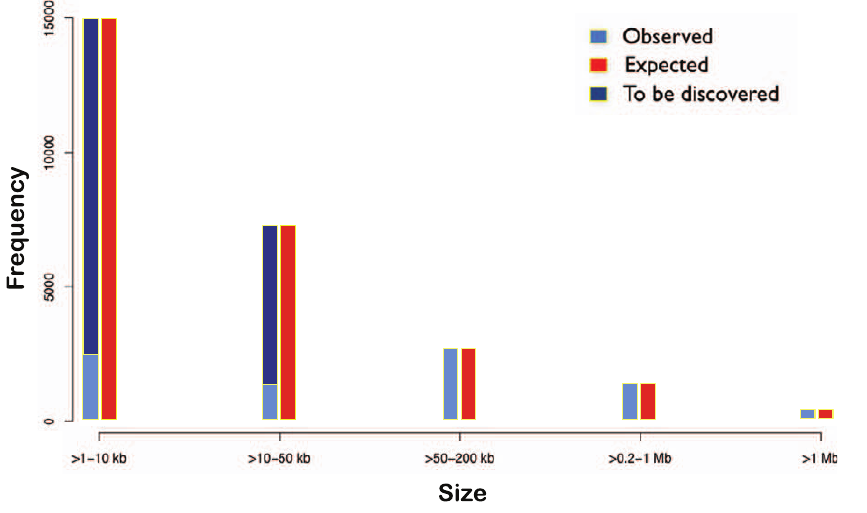
Figure 3. Expected and Observed Size Distribution of CNV Changes Identified to Date Blue bars represent the frequencies of the currently identified CNVs in the size ranges depicted in the x -axis. A plausible scenario of variation in CNV size frequency is depicted as red vertical bars. An under-detection of variable fragments of small size ( , 50 kb) can be observed, which is likely due to technological limitations in the high-throughput assays used so far to identify CNVs, largely based on array CGH (Figure 2). Observed and expected CNVs that are . 50 kb coincide, due to the powerful array methods, which cover the medium-to-large-size CNVs well. Dark blue bars represent the small-sized CNVs, which are more of a challenge to